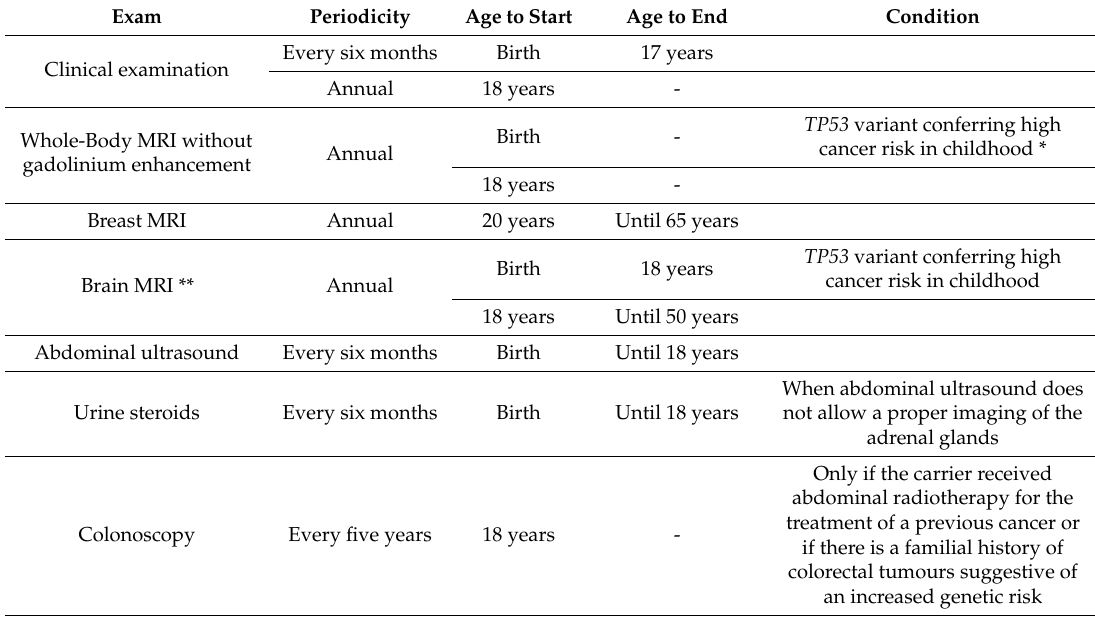
Table 2. Surveillance Protocol in Carriers of Germline disease-causing TP53 Variants (from reference